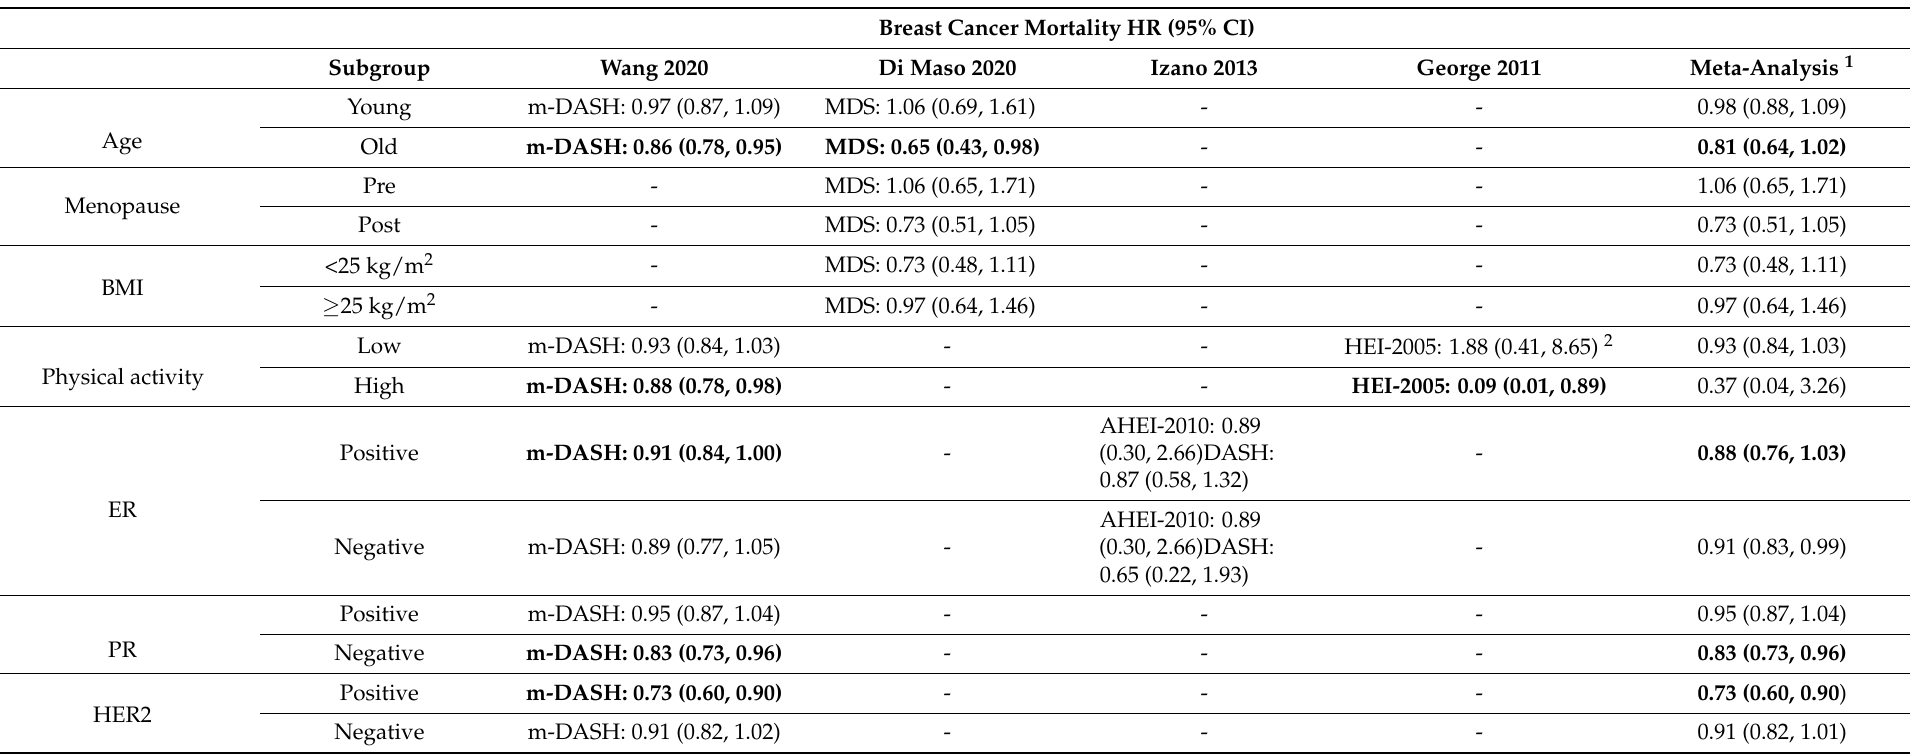
Table 5. Subgroup analysis by patient and clinical characteristics for breast cancer mortality comparing those in highest and lowest categories of diet